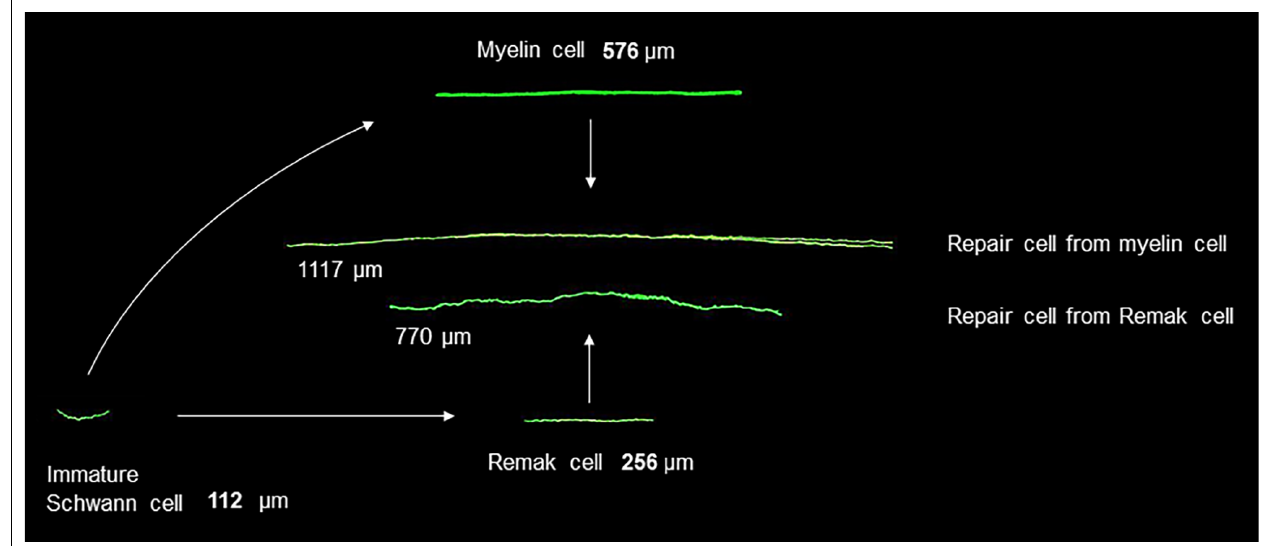
FIGURE 3 | Changes in Schwann cell size during development and after injury. Shown in green are fluorescent images of immature Schwann cells, myelin and Remak cells, and the repair cells derived from them. The cells are shown to scale and illustrate cells of average length. The images are obtained after genetic labeling in vivo (modified from Gomez-Sanchez et al.,